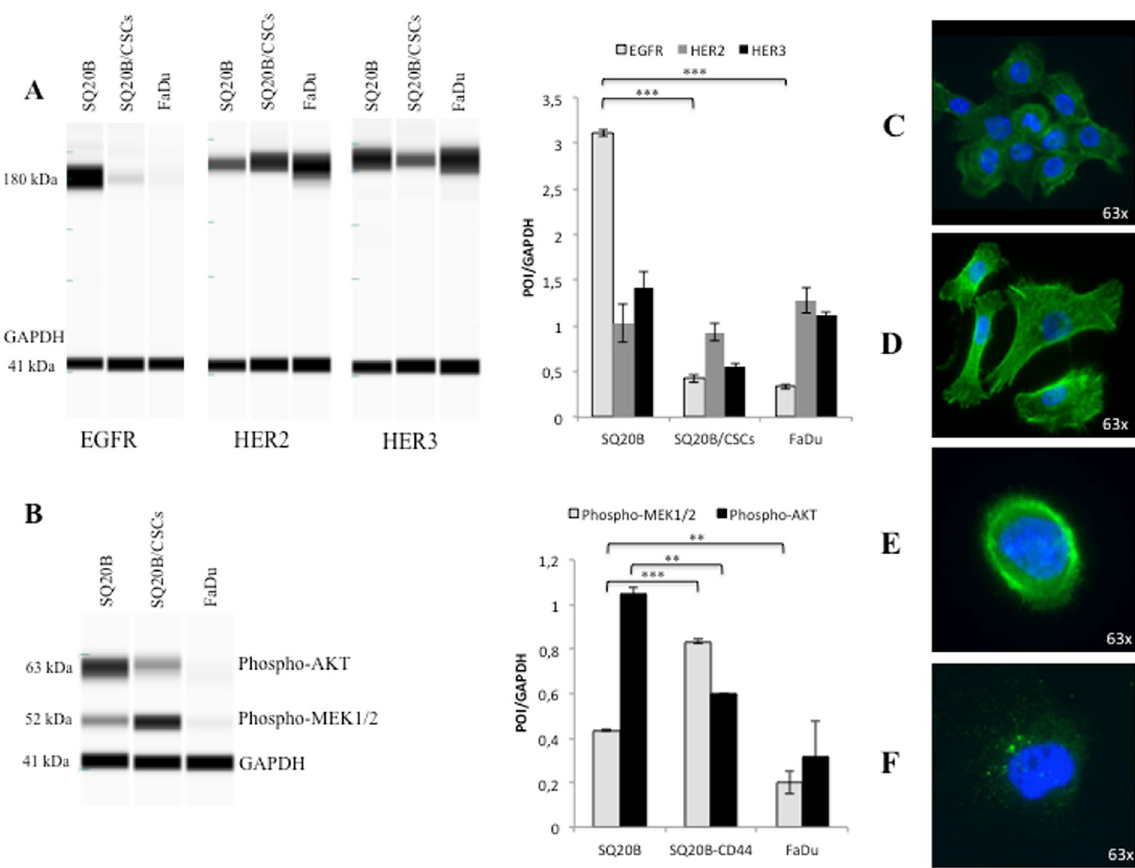
Figure 1. Basal characteristics of SQ20B cells , SQ20B-CSCs and FaDu cells . ( A ) EGFR (180 kDa), HER2 (184 kDa) and HER3 (189 kDa) basal expression in SQ20B cells, SQ20B-CSCs and FaDu cells. Protein expression was analysed with WES ™ (a simple western blotting technique using an automated capillary-based size sorting system) and expressed graphically as the GAPDH ratio. ( B ) Phospho-AKT (Ser473) (63 kDa) and phospho-MEK1/2 (Ser217/221) (52 kDa) basal expression in SQ20B cells, SQ20B-CSCs and FaDu cells. Protein expression was analysed with WES ™ , and expressed graphically as the GAPDH ratio (protein-of-interest (POI)/ GAPDH). ( C ) Microscopic observation (63 × ) of SQ20B cells stained with phalloidin (green actin) and DAPI (blue nucleus). ( D ) Microscopic observation (63 × ) of SQ20B-CSCs stained with phalloidin (green actin) and DAPI (blue nucleus). ( E ) Microscopic observation (63 × ) of a SQ20B cell stained with phospho-EGFR-FITC (green) and DAPI (blue nucleus). ( F ) Microscopic observation (63 × ) of a SQ20B-CSC stained with phospho- EGFR-FITC (green vacuoles) and DAPI (blue nucleus). Statistically significant differences are expressed as * p < 0.05, ** p < 0.01 and *** p < 0.001. Each experiment was performed in